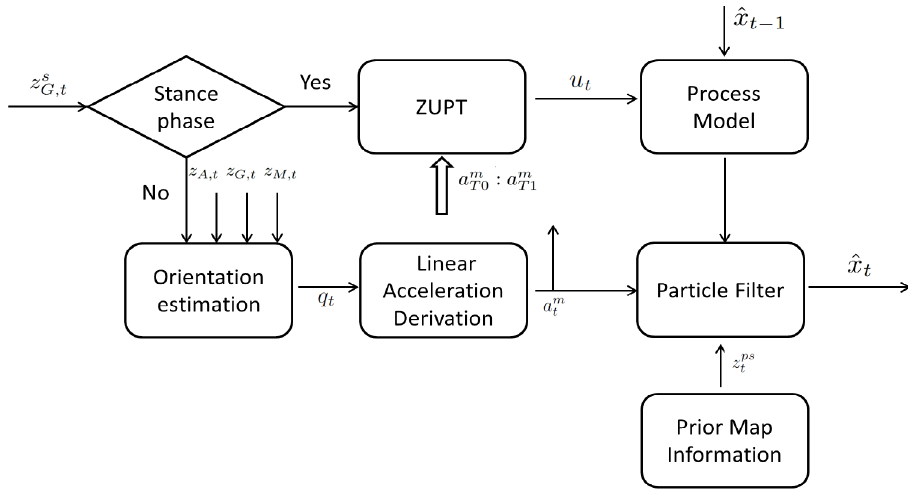
Figure 2. Flowchart of the proposed position tracking algorithm.